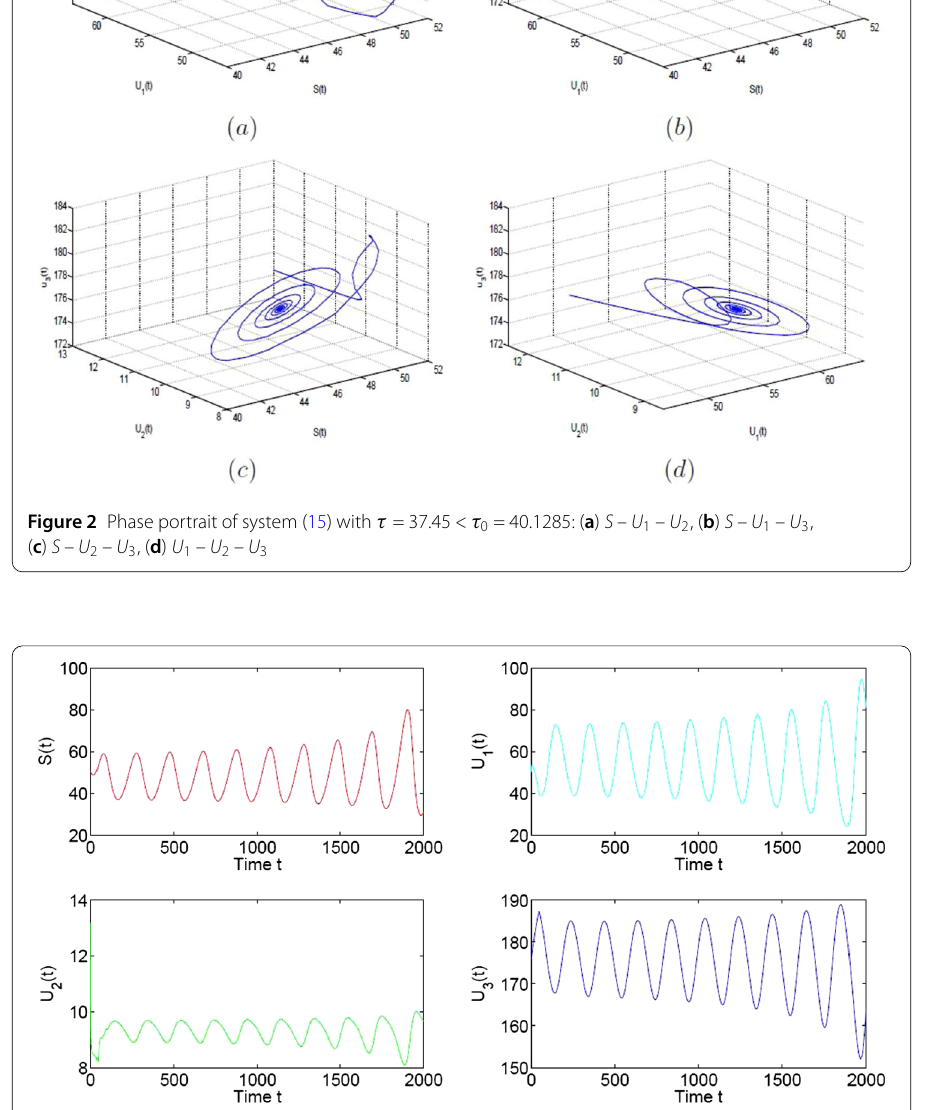
of A or β in system (15) increases; this can be demonstrated by Figs. 6–7. (ii) the